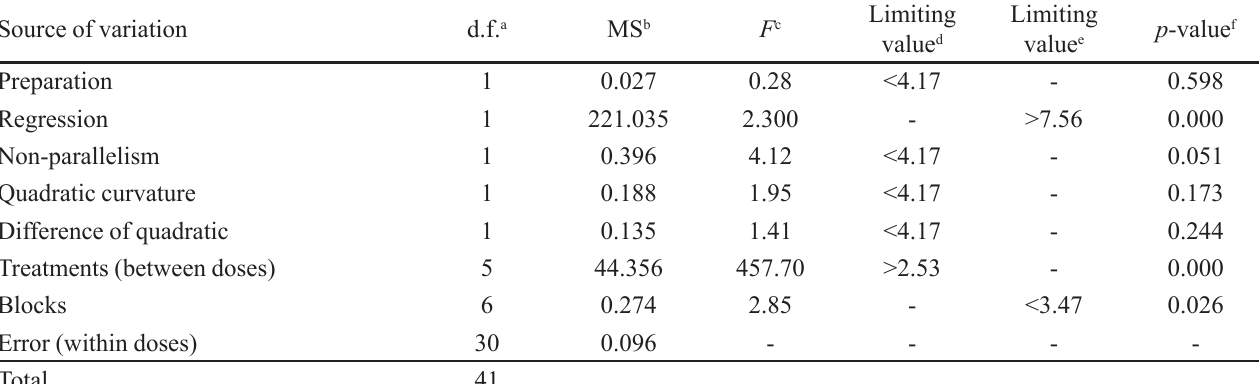
TABLE V - Analysis of variance (ANOVA) for the ofloxacin microbiological assay according to the Brazilian Pharmacopeia (FB) Source of